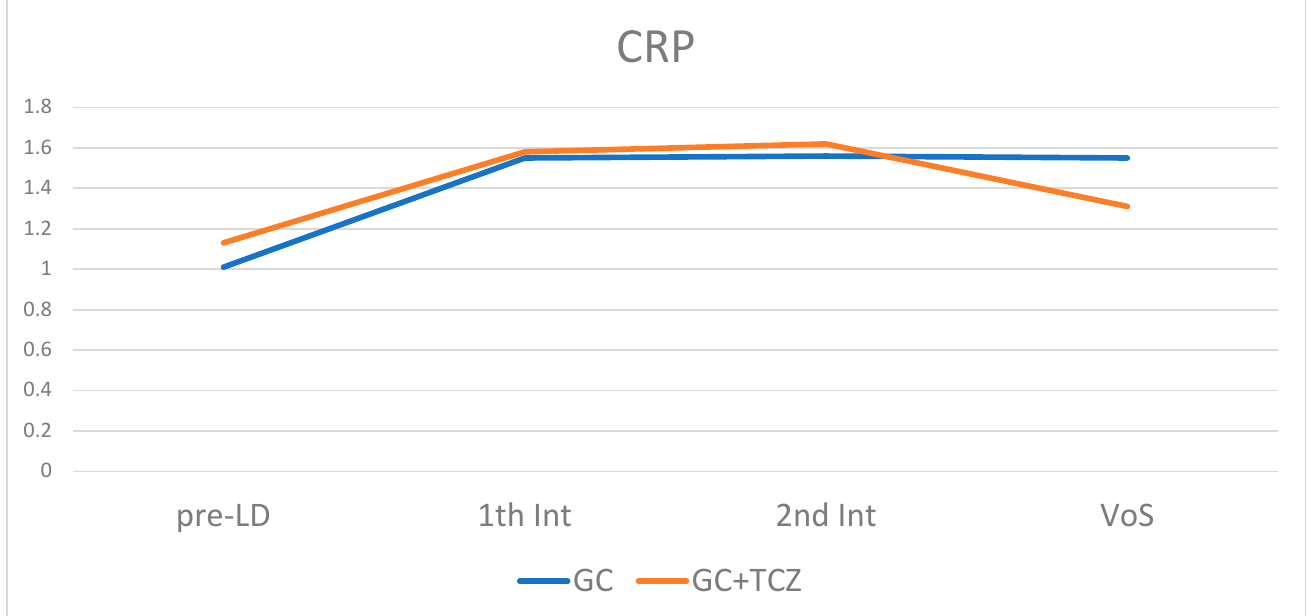
Figure 1. ESR trend during monitoring in the two di ff erent groups of patients treated with and without TCZ. ESR: erythrocyte sedimentation rate; GC: glucocorticoid; TCZ: tocilizumab; pre-LD: pre-lockdown visit; 1th Int: fi rst interview; 2nd Int: second interview; VOS; visit on site.